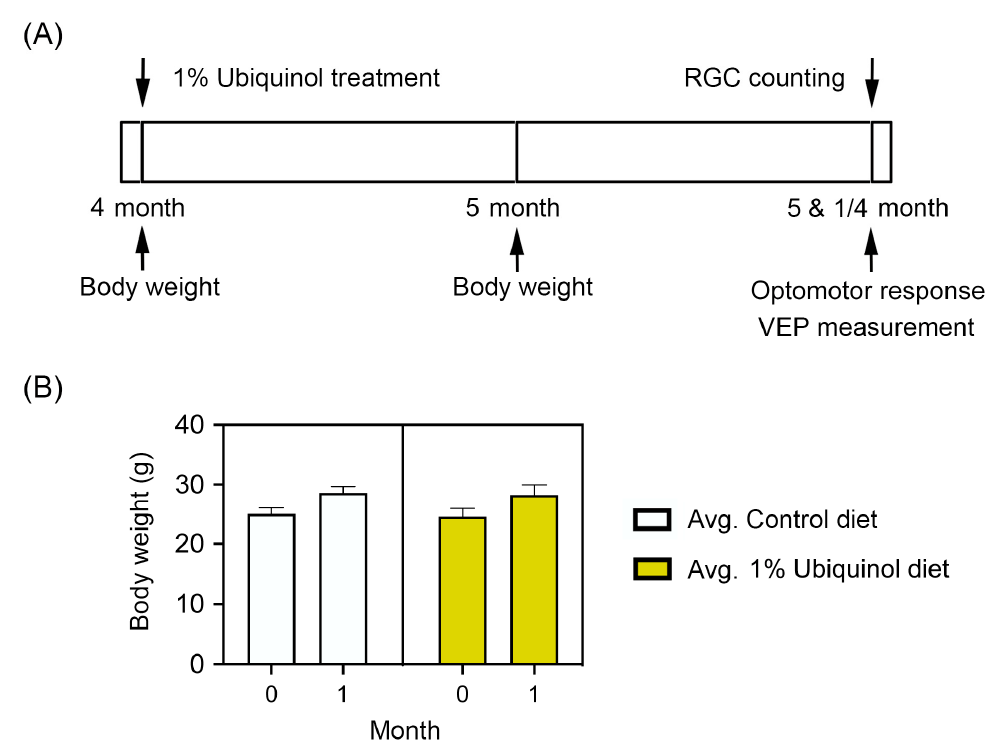
Figure 6. Ubiquinol supplementation in paraquat (PQ)-induced C57BL / 6J mice. ( A ) Diagram for control and ubiquinol diet (1%) supplementation and measurements for body weight, optomotor response, visual evoked potential (VEP) and RGC survival. Four month old C57BL / 6J mice were fed with either an unsupplemented control diet or the ubiquinol diet daily for 1 month. The control and ubiquinol diet were given daily on chow. ( B ) Body weight in control and ubiquinol diet-treated mice. Data are expressed as mean ± SEM ( n = 10 for C57BL / 6J mice / group). Table 2. E ff ect of ubiquinol on Brn3a-positive RGCs in the middle area of oxidative stress-induced C57BL / 6J retinas. 2164 ± 106 ****